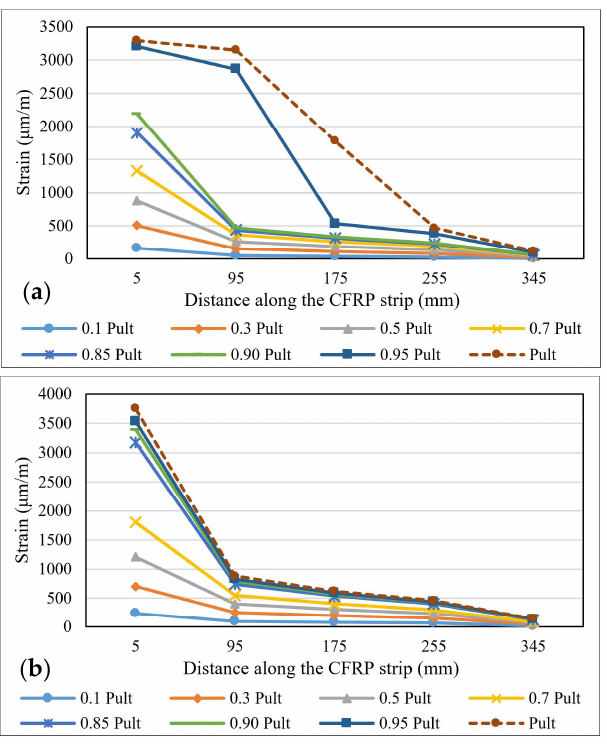
Figure 12. Strains distribution along the bond length for specimens: ( a ) NS-S512-30-1-I and ( b ) S-M514-330-3-I.